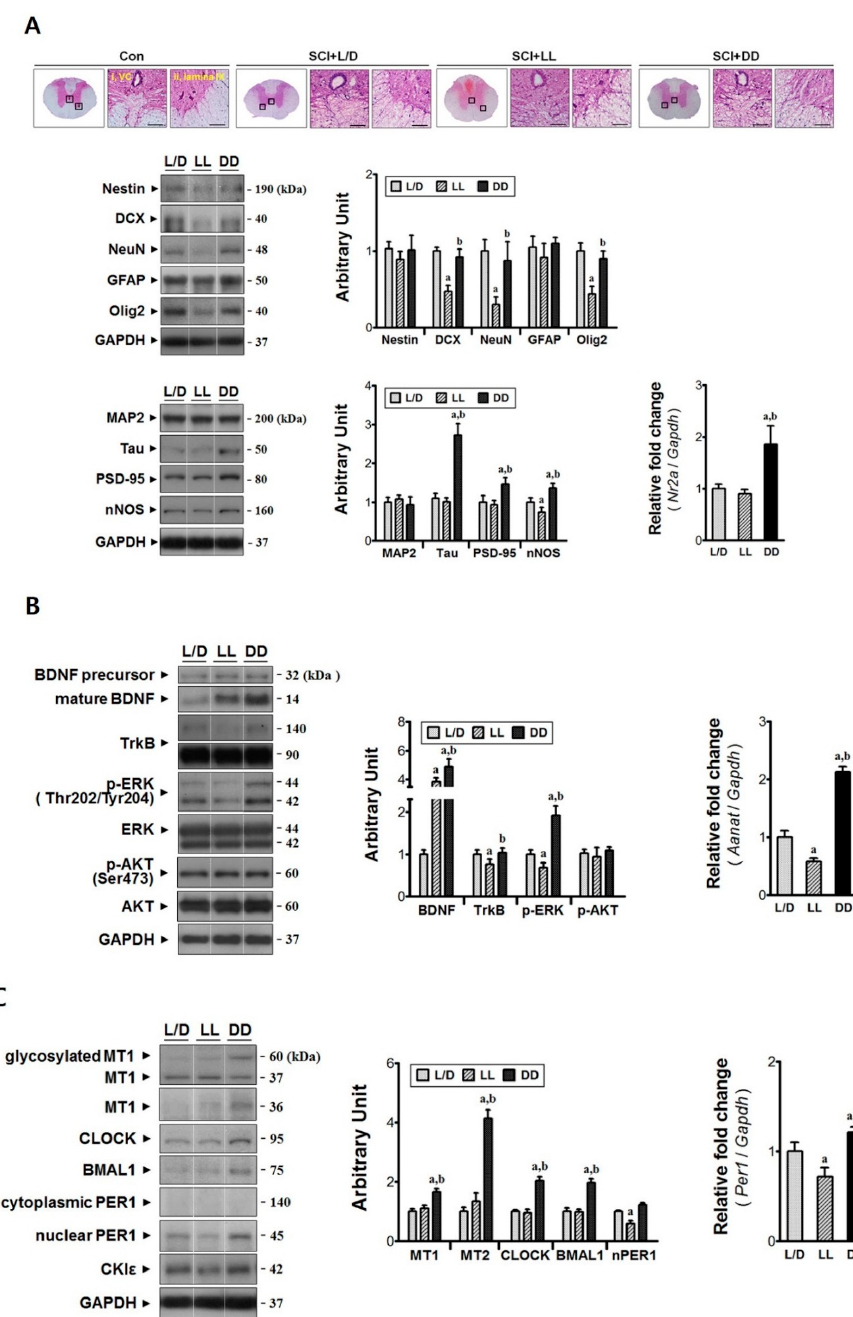
Figure 4. Constant dark condition accelerates excitatory synapse formation and axonal outgrowth in the rostral region via TrkB-ERK signaling pathway. The mid-thoracic segments (T6-8) were analyzed at POD 3. ( A ) The animals under LL condition showed hemorrhage in dorsal white column, interrupted neurite outgrowth, and massive loss of immature (DCX) and mature neurons (NeuN) after spinal cord injury. The DD condition promoted not only excitatory synaptic formation (PSD-95, nNOS, Nr2a ) but also axonal outgrowth (Tau) compared with the L/D group. VC, ventral commissure; Magnification = × 200; Scale bar = 40 µ m; ( B ) TrkB-mediated ERK signal transduction was enhanced under DD condition, while LL condition decreased their activation in spite of the higher level of BDNF. Transcriptional regulation of Aanat gene was affected by the light/dark condition; ( C ) DD condition increased the core clock proteins (CKOCK, BMAL1, nuclear PER1) as well as mRNA ( Per1 ) in the rostral region. The level of melatonin receptor 1A (MT1) and 1B (MT2) was greater in the SCI + DD group than those of other groups. L/D, 12/12-h light/dark; LL, 24-h constant light; DD, 24-h constant dark. a p < 0.05 vs. L/D; b p < 0.05 vs.